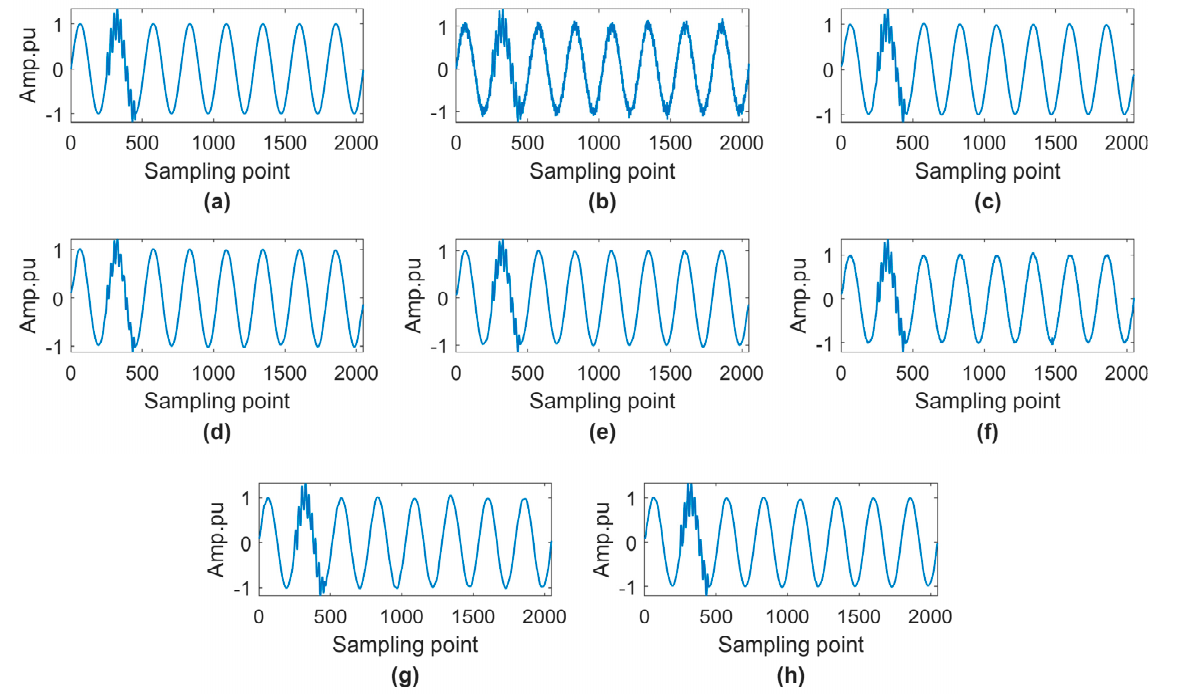
Figure 4. ( a ) Noiseless oscillation transient; ( b ) oscillation transient with a SNR of 20 dB; ( c ) hard thresholding denoising; ( d ) soft thresholding denoising; ( e ) denoising following the method described in Ref. [1]; ( f ) denoising following the method described in Ref. [2]; ( g ) denoising following the method described in Ref. [27]; ( h ) denoising following the proposed method processing.